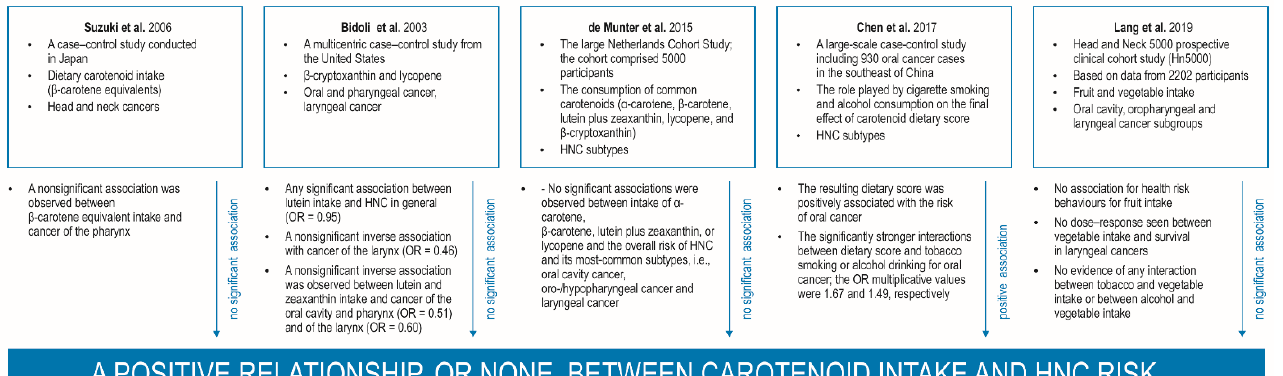
Figure 5. The representative scientific articles confirming a positive relationship, or none, between carotenoid intake and HNC risk [185,189,191,192,199].